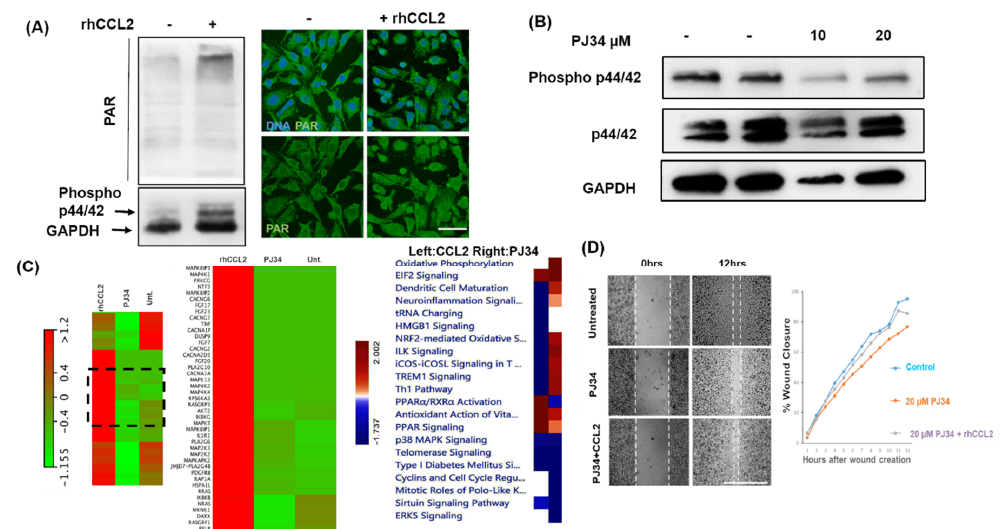
Figure 5. PARP1 and CCL2 crosstalk regulate invasiveness in breast cancer. ( A ) Left: Recombinant human CCL2 (rhCCL2) can increase PAR levels in MB-231 cells. MB-231 cells were serum-starved overnight and treated with 50 ng/mL rhCCL2 for 1 h. Western blot showing total PAR level upon treatment. Right: Immunofluorescence images showing PAR (green) in cells after rhCCL2 treatment. An enlarged image in Figure S8. Merged image with DNA (DAPI) shown on top. Scale bar 20 µm. ( B ) PARP1 inhibitor treatment reduces phosphorylated P44/42 (ERK1/2) levels in MB-231cells. Western blot showing Phospho-p44/42 ERK1/2 (Thr202/Tyr204) and total ERK1/2 after overnight PJ34 treatment followed by 45 min of TNFα. ( C ) Left: Heat map showing transcriptome analysis from MB-231 cells for rhCCL2 (1 h treatment as in A ) and PJ34 (10 µM Overnight treatment) treated groups. The KEGG MAP kinase pathway genes are identified. Red color indicates upregulation with green, showing the downregulation of mRNA transcription. Right: Ingenuity pathway analysis from rhCCL2 (Left column) and PJ34 treated (right column). Enlarged images of ( C ) are in Figure S8. ( D ) Wound healing assay with simultaneous rhCCL2 and PJ34 treatment on MB-231 cells. Near confluent cells were pretreated with PJ34 before rhCCL2 was added at the dose of 50 ng / mL after wound creation. Treatment was continued for 12 h. The graph on the right shows % wound closure with respect to time. Scale bar 100 µ m. Whole western blots for 5A and 5B are in Figure